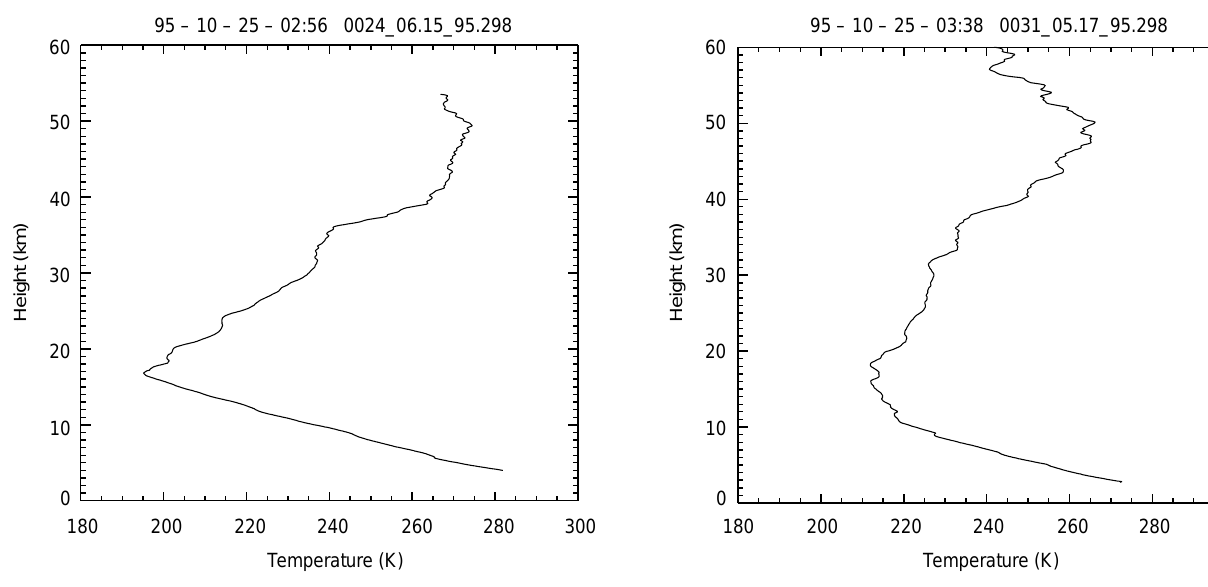
Fig. 10. Periodic structures in the temperature profile, especially in the height range 30–45 km but also below (25 Oct. 1995, 3:38 UT, 37 (cid:14) N lat, 66